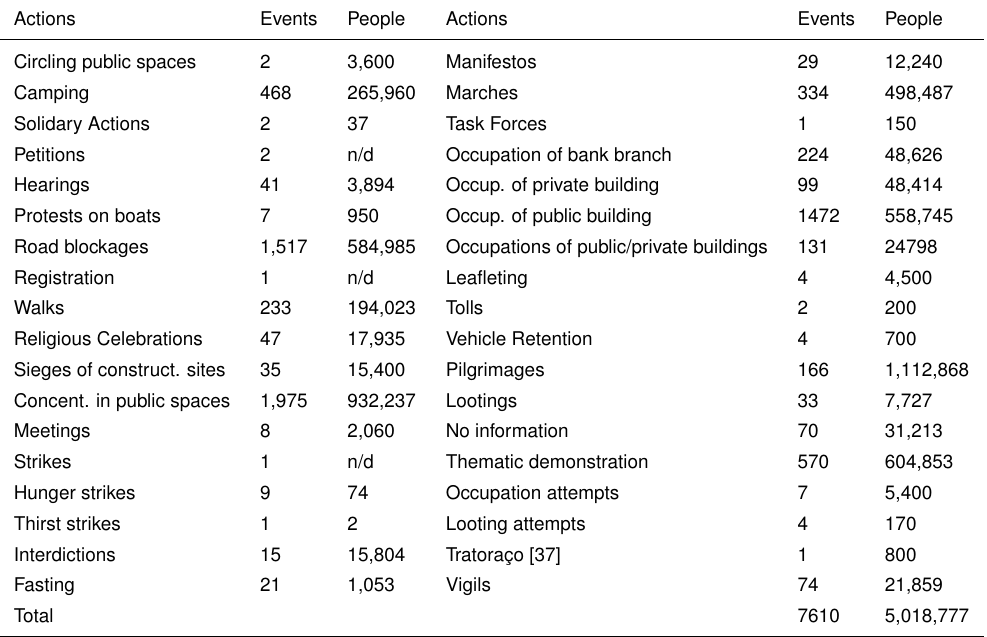
Table 2. Different manifestations organized to gain visibility for the struggle for land,